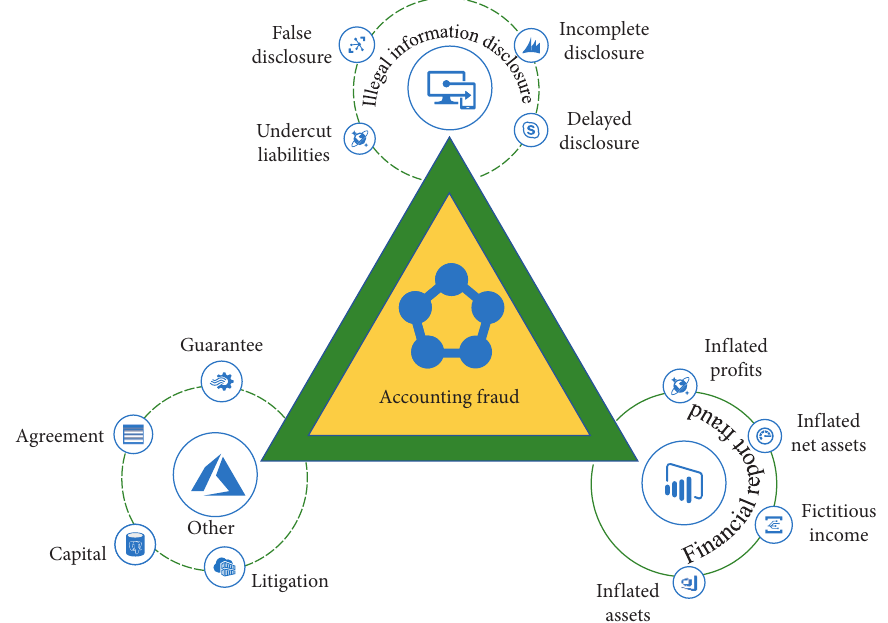
Figure 3: Analysis framework of accounting